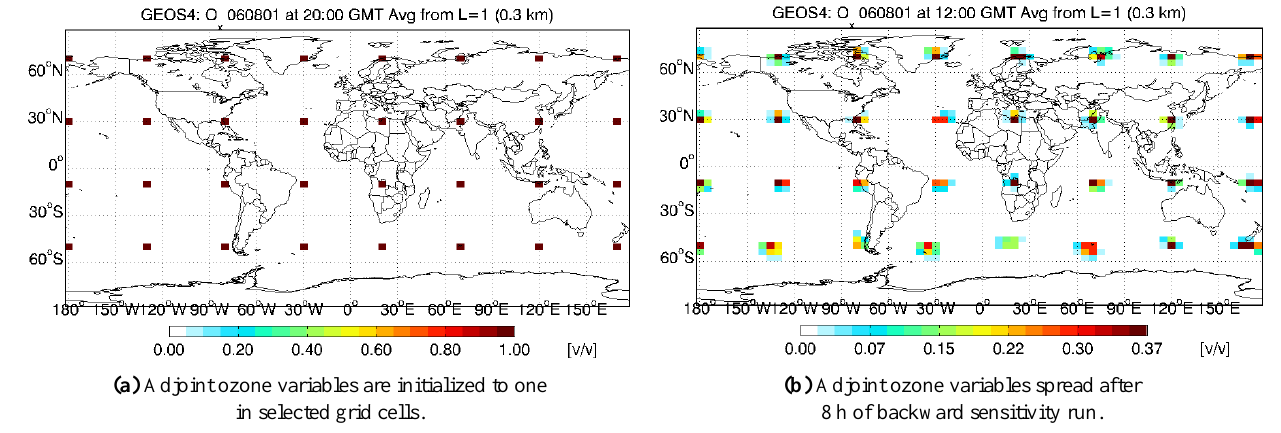
Fig. 8. Ground level ozone adjoint variable values are initialized to one on 1 July 2006, 20:00GMT, every tenth grid point in longitudinal and latitudinal directions. An 8-h backward adjoint integration spreads the adjoint fields, and helps identify grid cells where ozone errors are